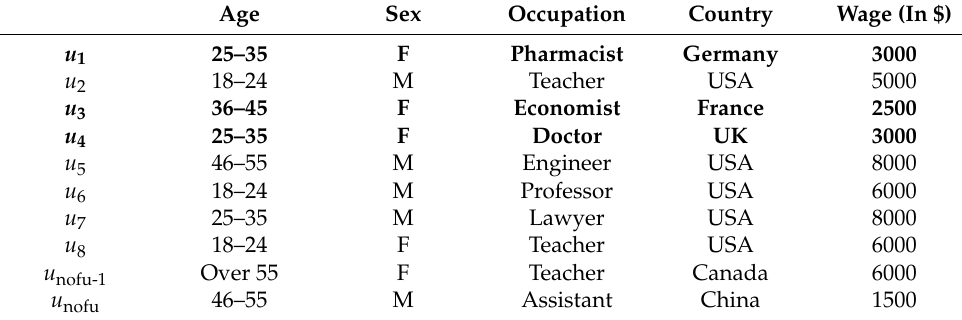
Table 1. User matrix UM.